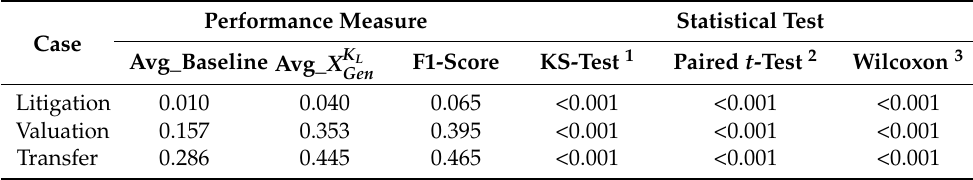
Table 5. Results of statistical tests for Hypothesis